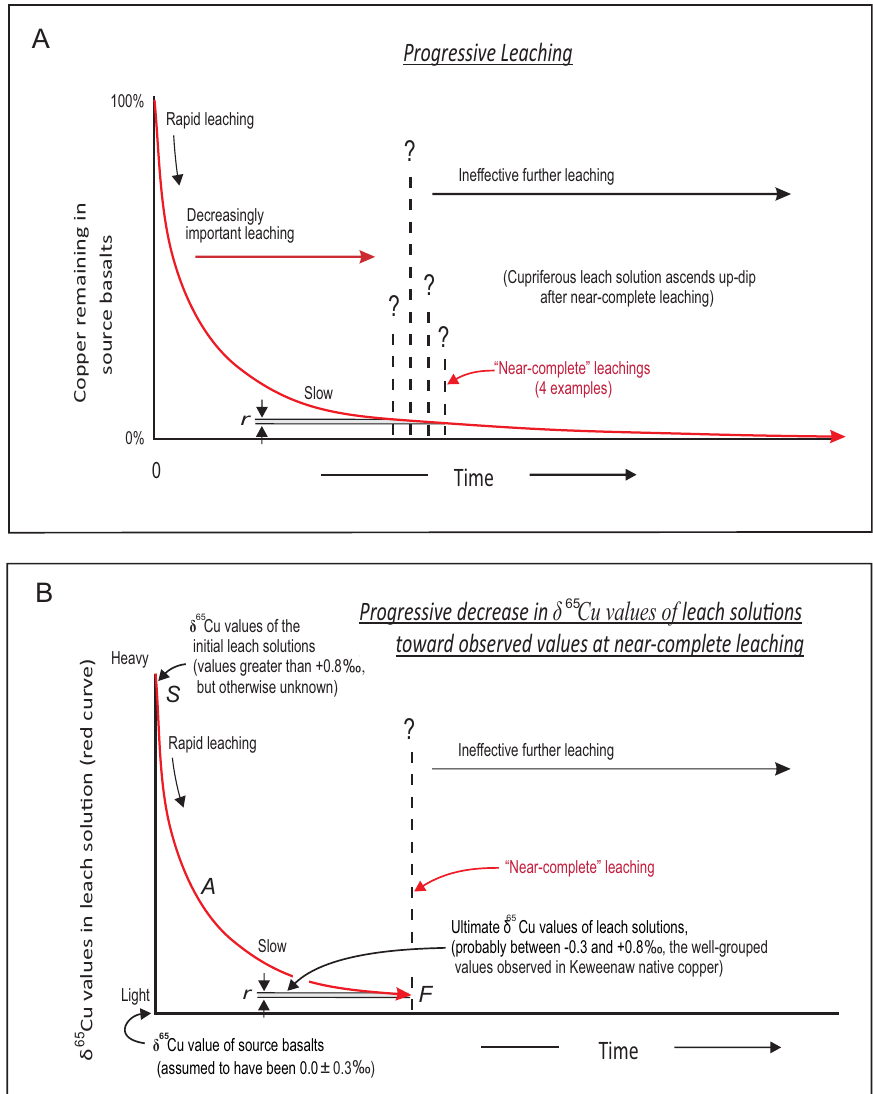
Figure 2. A reinterpretation of progressive copper isotopic fractionation during the oxidative leaching of copper from deeply buried Portage Lake Volcanics (PLV) basalts, based on common geologic expectations. ( A ) Metamorphogenic leaching of trace-level copper from source basalts can be expected to have initially been rapid, and then to have progressed in ever slower increments, until, at near-complete leaching, negligible amounts of copper remained in the source basalts (see range r for four samples illustrated in this schematic diagram). ( B ) Similar to (A), but with the vertical axis representing δ 65 Cu values. Initially, leached copper would have been heavy (greater than 0.8 according to Bornhorst and Mathur), but would have evolved toward a narrow range of (cid:104) lighter values (see r ; e.g., − 0.3 to +0.8 , as observed in 120 analyses of Keweenaw native copper) (cid:104) at near-complete leachings, as a result of continued leaching of ever lighter residual copper in the source